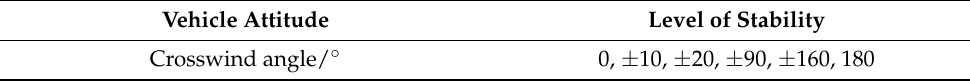
Table 5. Variation conditions of crosswind angle of vehicle attitude stability.